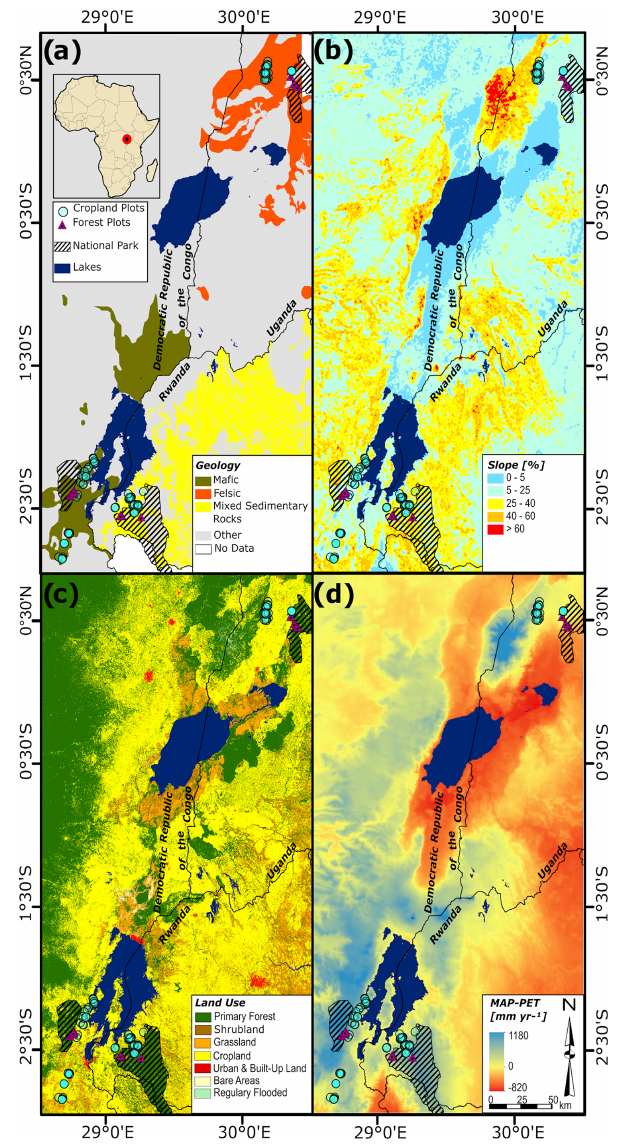
Figure 2. Overview of the study region with respect to major in- vestigated factors: soil parent material geology and geochemical re- gions (a) , slope steepness (b) , land use (c) , and climate (d) (data sources: Farr et al., 2007; Fick and Hijmans, 2017; Friedl et al., 2013; Dewitte et al., 2013; Dressée et al., 1949; Trabucco and Zomer et al., 2018; Verdooht and Van Ranst,